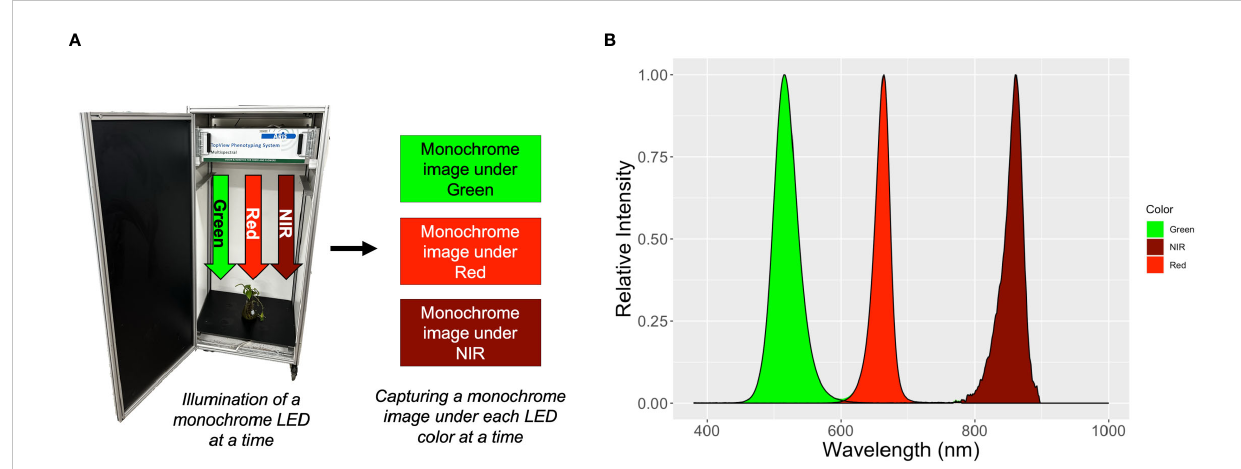
FIGURE 1 Schematic representation of the acquisition process of green, red, and near-infrared (NIR) spectral images by the TopView multispectral imaging system (A) and the normalized spectrum of the LEDs of the system used for capturing each monochrome image (B) . The peak and full width at half maximum of green, red, and NIR LEDs were 516 and 40 nm, 664 and 25 nm, and 861 and 28 nm,